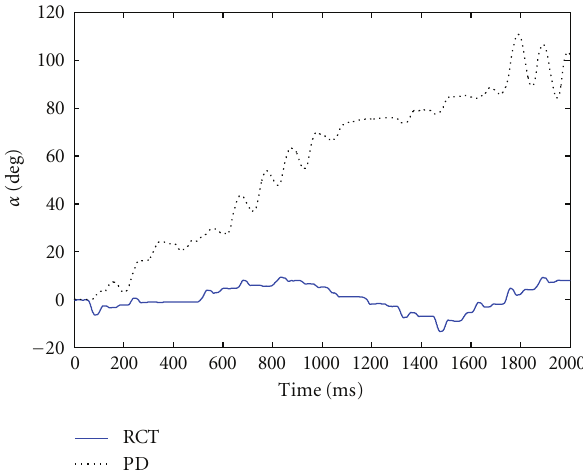
Figure 16: Heading angle comparison of PD (black dotted line) and RCT control (blue solid